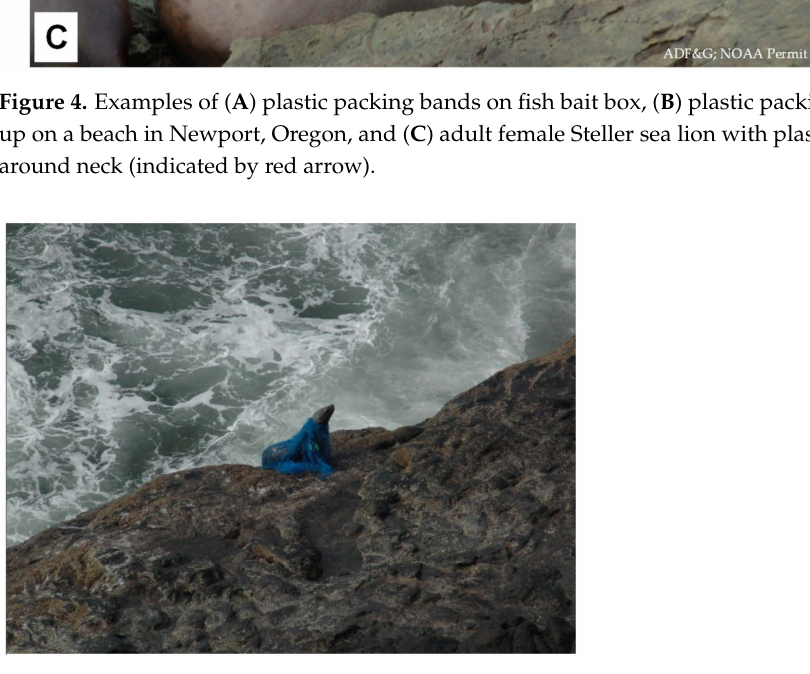
Figure 5. Juvenile Steller sea lion entangled in large net of unknown origin at Sea Lion Caves, Oregon.